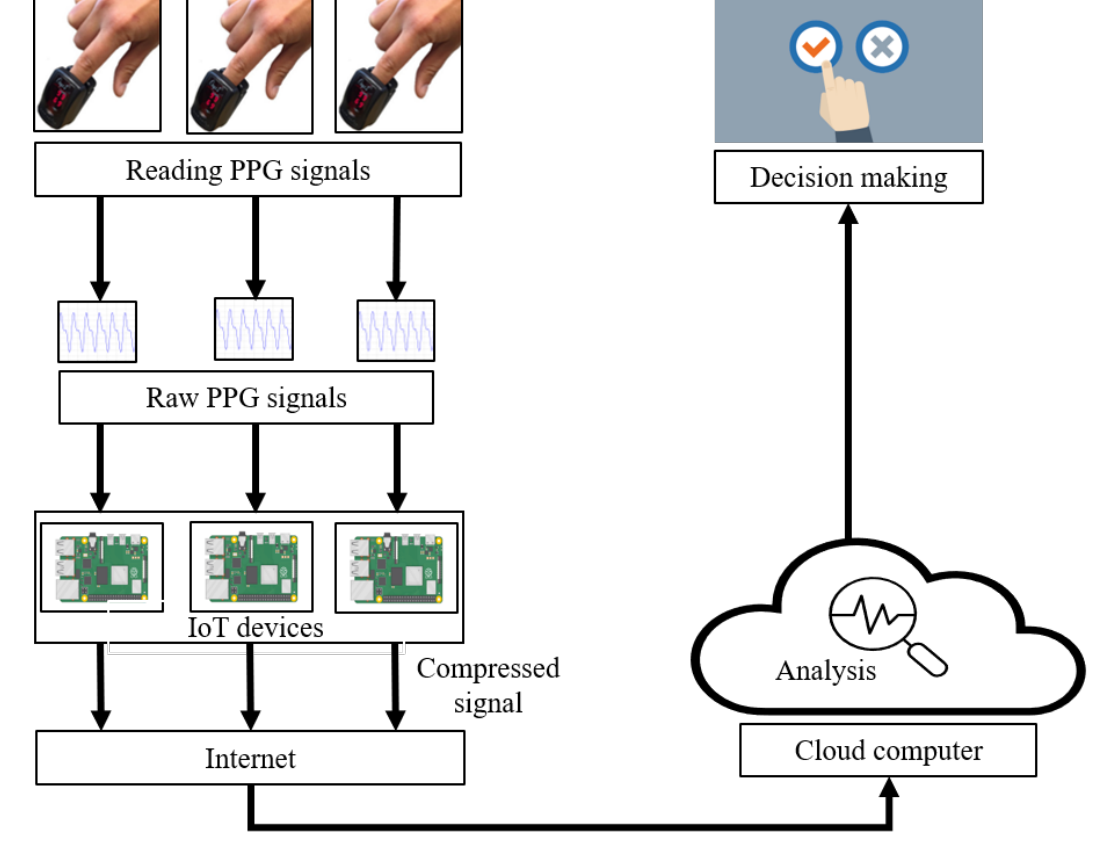
Figure 1. System